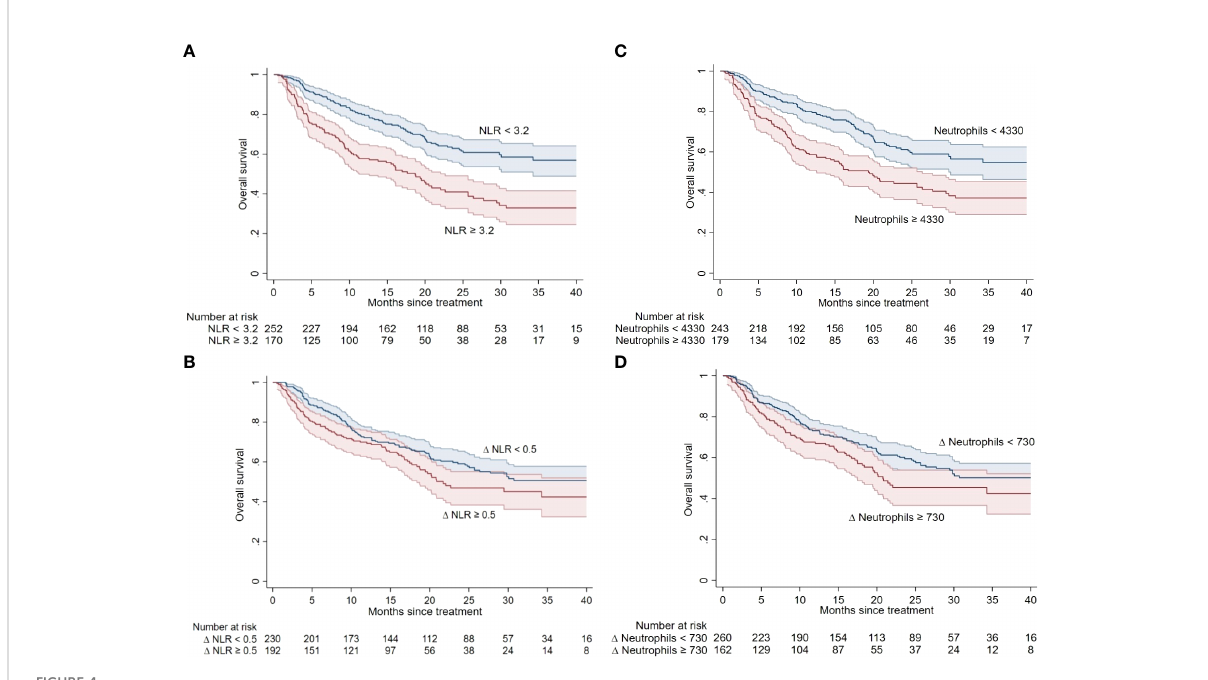
FIGURE 4 The univariable analyses of baseline and early D of NLR (A, B) and neutrophils (C, D)